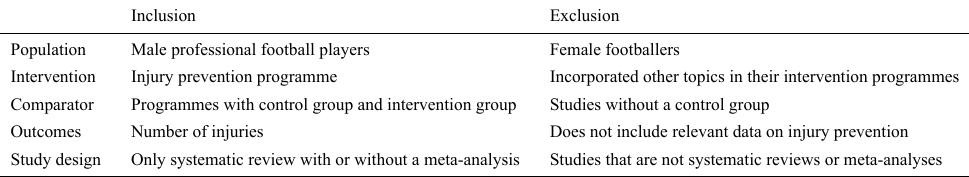
Table 1. Inclusion and exclusion